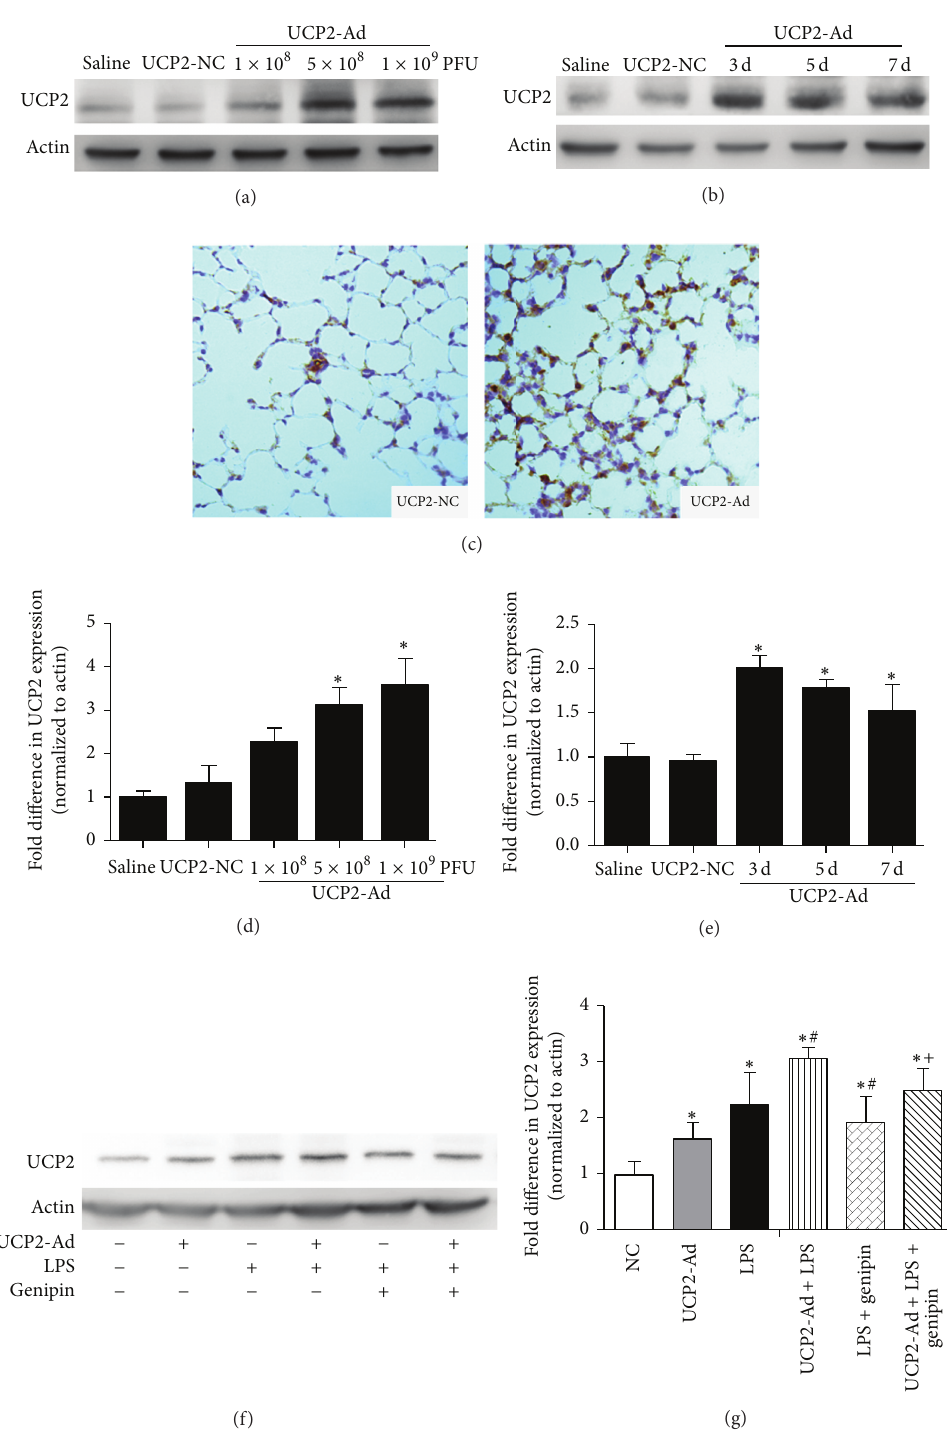
Figure 1: Regulation of UCP2 expression by UCP2 recombinant adenovirus or genipin in mouse lungs. (a) Western blot analysis detected UCP2 expression in lung homogenates of mice after intranasal administration of saline, UCP2-NC, or different UCP2-Ad virus doses (1 × 10 8 , 5 × 10 8 , or 1 × 10 9 pfu/mouse). (b) Western blot analysis detected UCP2 expression in lung at 3, 5, and 7 days after administration of saline, UCP2-NC, or UCP2-Ad virus at a dose of 5 × 10 8 pfu/mouse. (c) Immunohistochemical analysis of UCP2 overexpression with an antibody specific to mouse UCP2 (brown color) in the control group treated with UCP2-NC virus (control) and the UCP2-Ad-treated group (400x). (d, e) Densitometric analysis of UCP2 immunoreactive bands is shown as fold difference in UCP2 expression normalized to actin expression ( 𝑛 = 3 , ∗ 𝑃 < 0.05 versus the saline group (control)). (f, g) Western blot analysis detected the role of genipin in UCP2 expression in lung tissue ( 𝑛 = 3 , ∗ 𝑃 < 0.05 versus the saline group, # 𝑃 < 0.05 versus the LPS group, + 𝑃 < 0.05 versus the UCP2-Ad + LPS group). Values are presented as means ±